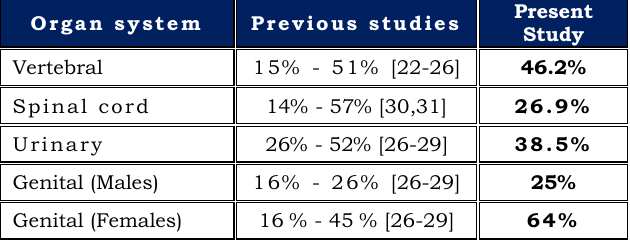
Table 6: Reported incidence of Organ System Involved with additional anomalies in